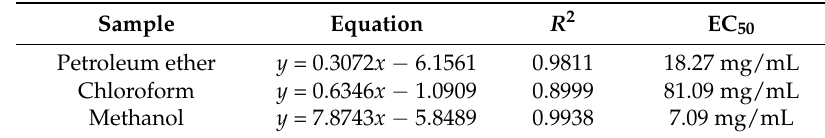
Figure 1. Antioxidant activity (percent of inhibition) of Pereskia aculeata extracts. Table 2. Straight equation used to calculate EC 50 antioxidant activity of Pereskia aculeata extracts.